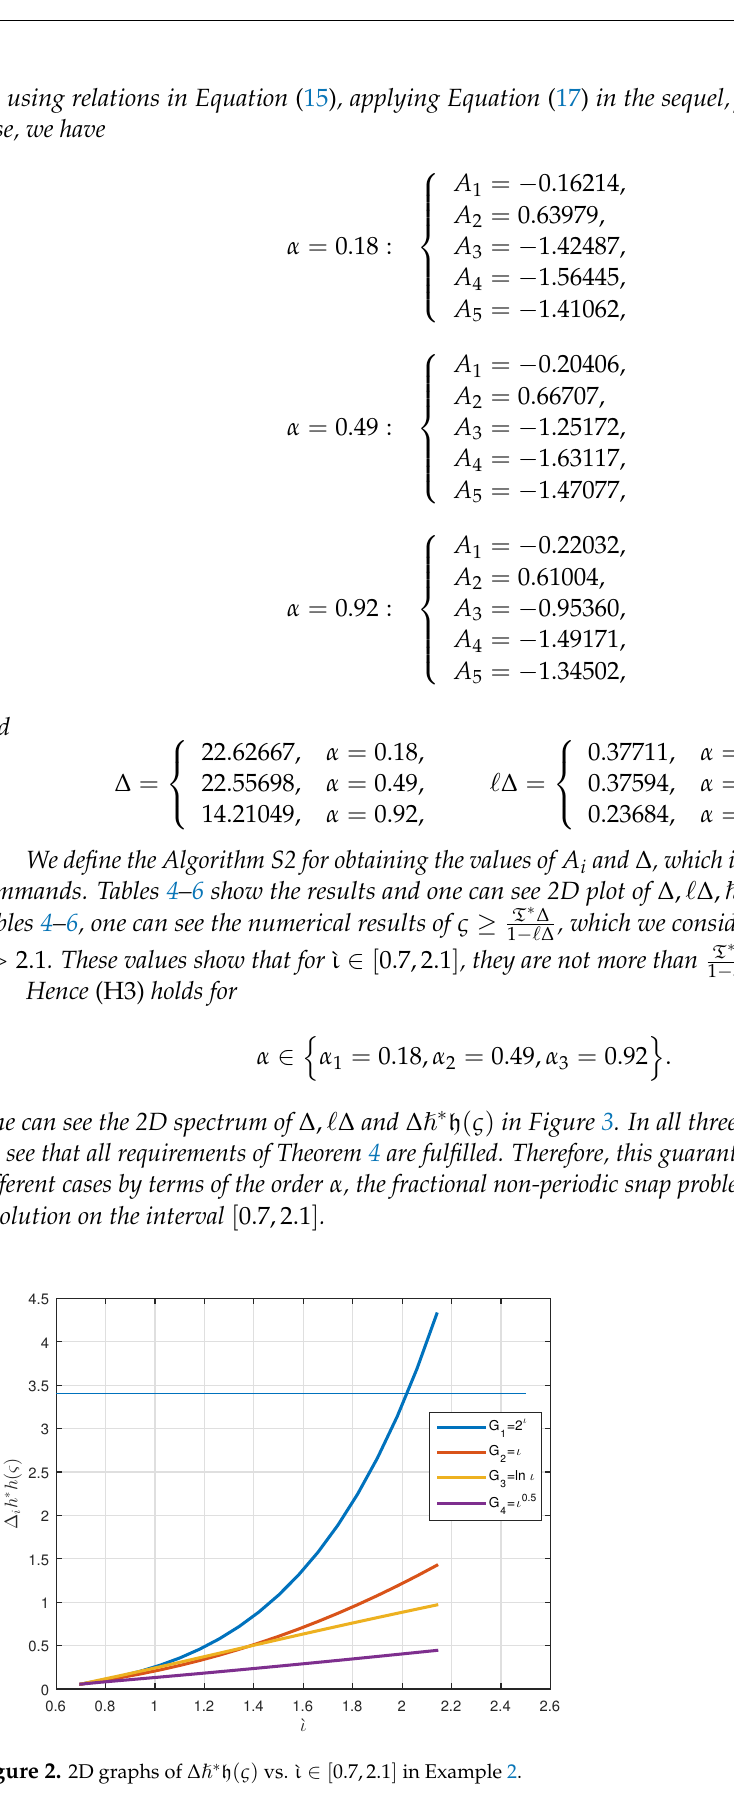
Figure 2. 2D graphs of ∆ (cid:125) ∗ h ( ς ) vs. ` ι ∈ [ 0.7,2.1 ] in Example